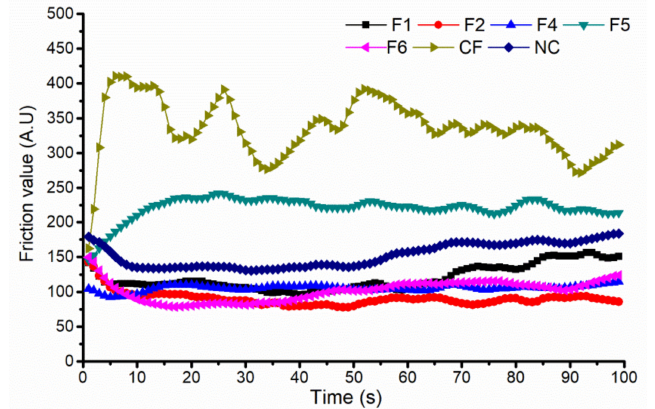
Figure 3. Friction curves obtained 5 min after application of the developed film-forming systems on the volar forearm area in comparison with the bare skin (non-treated control). Data represent the mean value obtained for 8 volunteers.